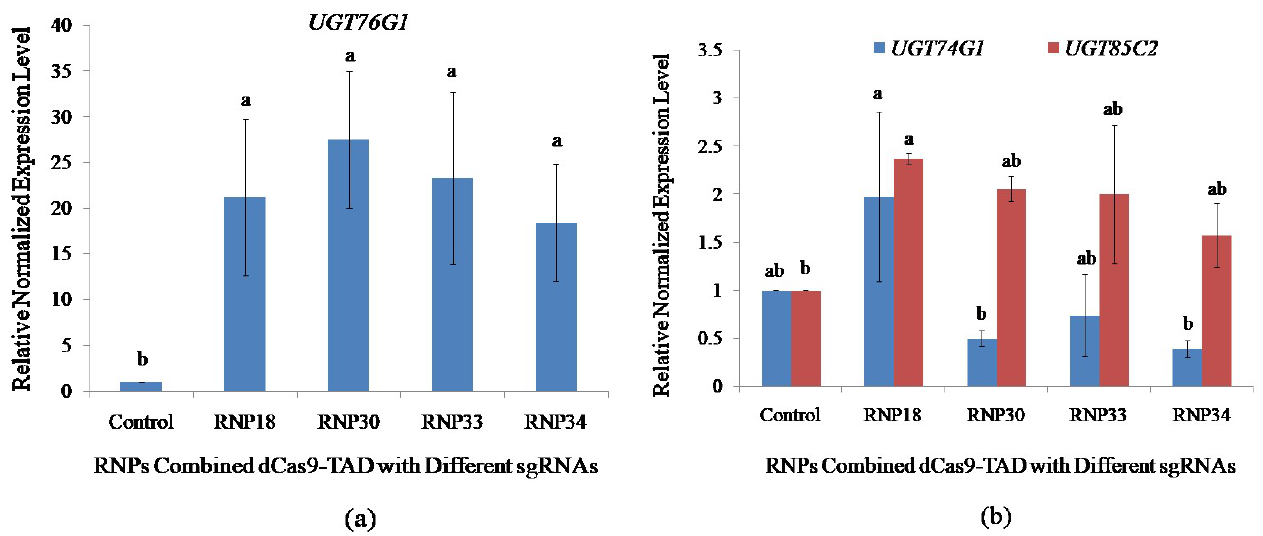
Figure 4. Impact of sgRNA positions on the activation of UGT76G1 in transfected protoplasts and the effect of UGT76G1 activation on the expression of other rebaudioside A biosynthetic pathway genes ( UGT74G1 and UGT85C2 ). qPCR was performed on the stevia protoplast transfected with the different RNPs combination of dCas9-VP64 with sgRNAs targeting different proximal promoter positions of UGT76G1 . ( a ) Positional impacts of sgRNAs on transcriptional activation level of UGT76G1 ; and ( b ) Effects of activating UGT76G1 on the expression of other key biosynthetic pathway genes. The expression was normalized with three reference genes; Actin, Aquaporin , and Calmodulin . Bars denoted the mean of three biological replications per treatment ± SE (Standard Error). Mean values with the same letters are not significantly different based on the student’s t-test at p = 0.05 .